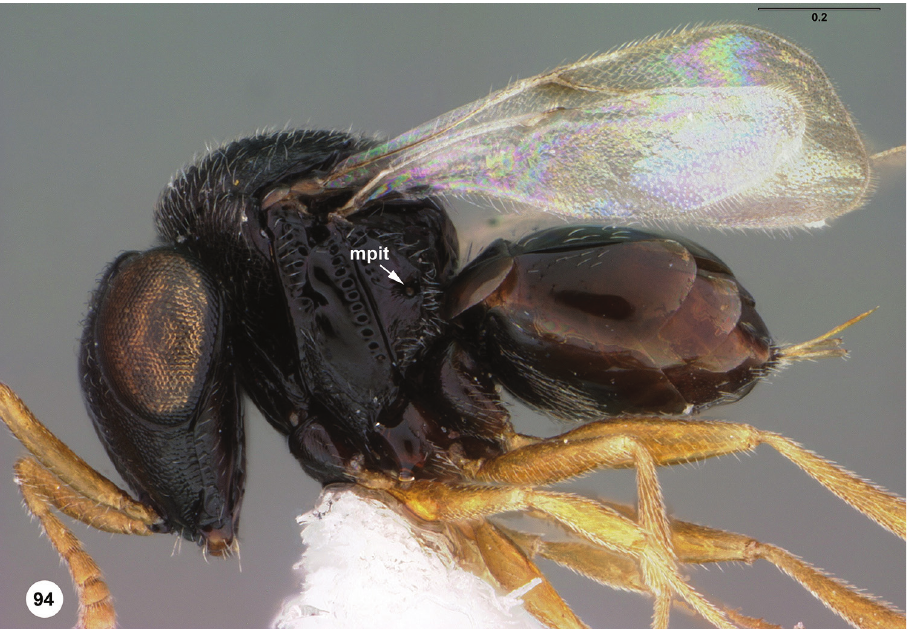
Figures 94. Trissolcus larides female (USNMENT00896166), head, mesosoma, metasoma, lateral view. Scale bars in